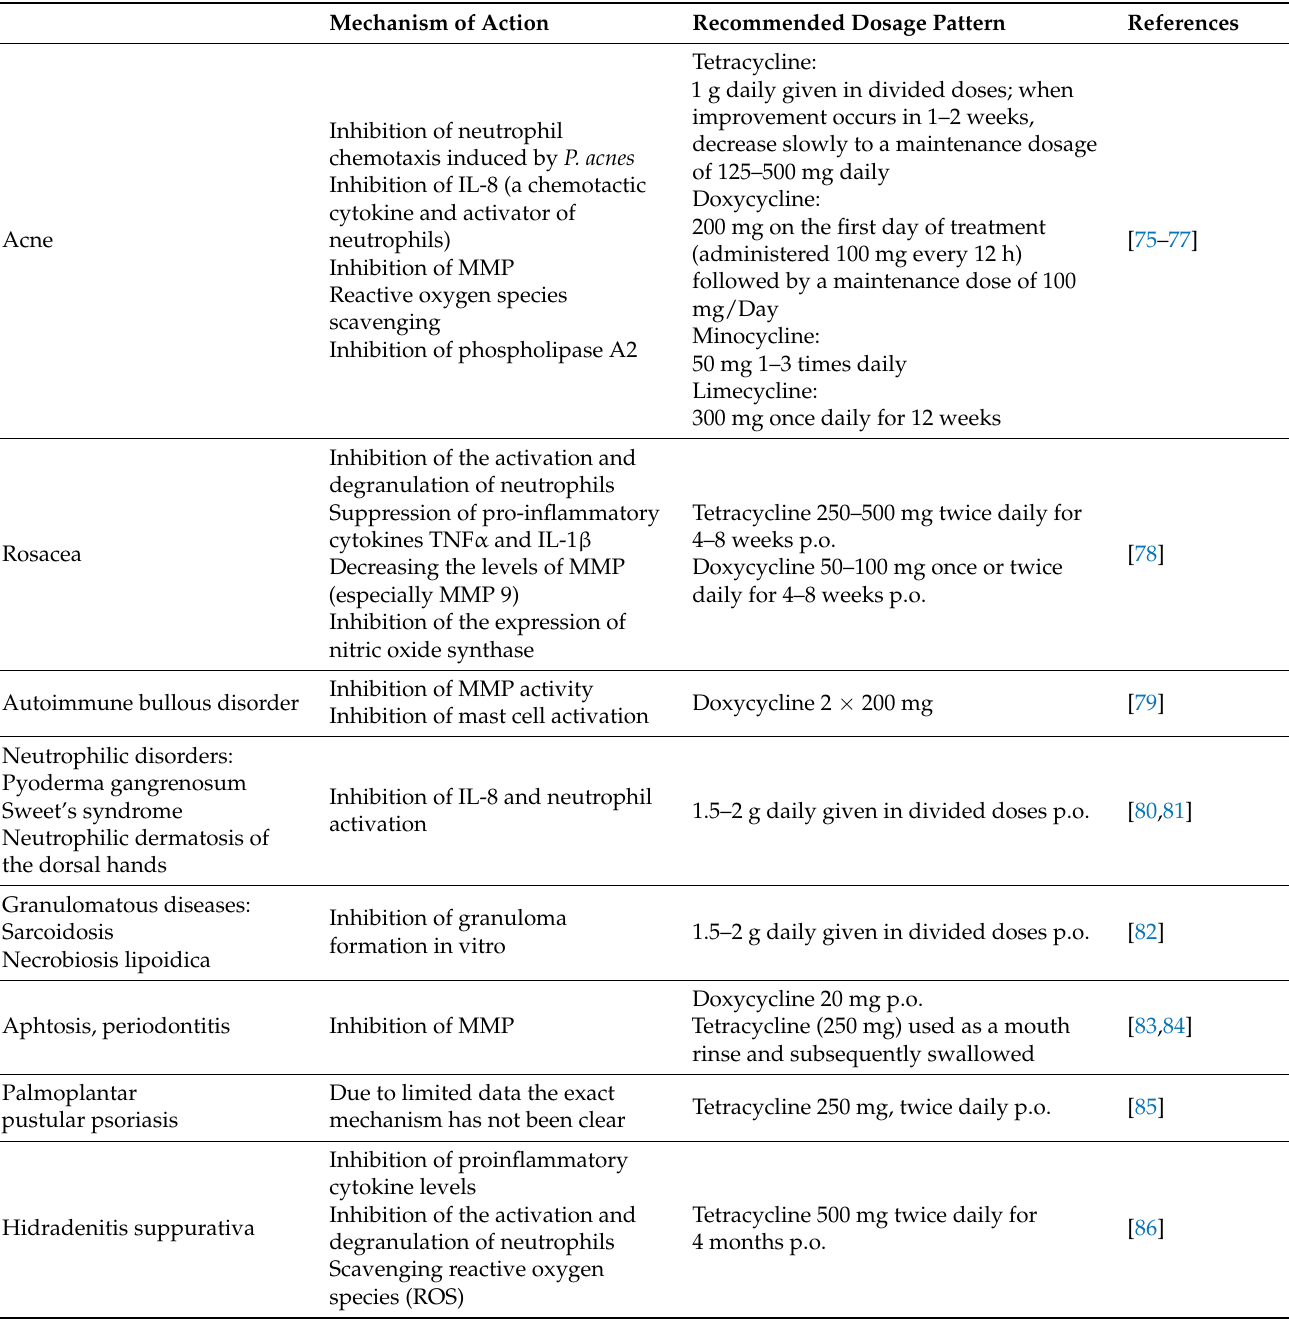
Table 3. Non-antibiotic activity of tetracyclines—use in inflammatory diseases. Mechanism of